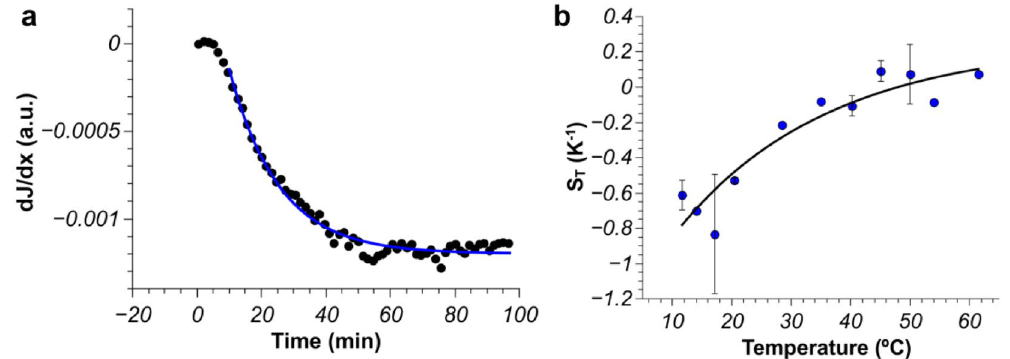
Figure 2. Thermophoretic behavior of β -lactoglobulin fibrils. ( a ) Typical gradient of the fluorescence intensity ( dJ / dx ) of fibrils measured across the microchannel during a thermophoretic experiment (c = 0.5% w/w, average T = 12 °C, Δ T = 14 °C/mm). The temperature gradient is imposed at time t = 0 . ( b ) Variation of the Soret coefficient, S T , with the average temperature. The solid line is a fit to the equation suggested by Iacopini and Piazza 33